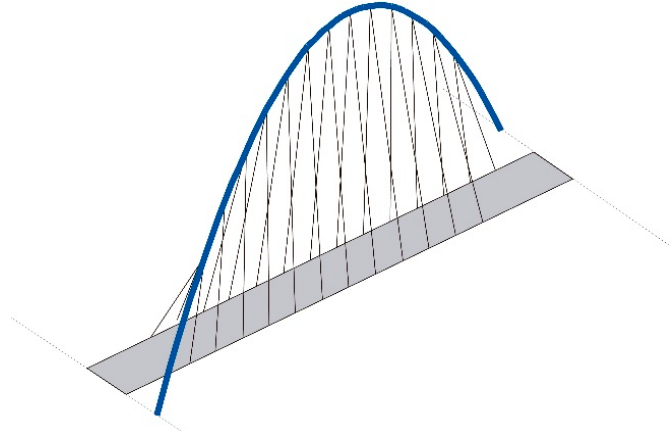
Figure 2. Schematic illustration of a diagonal arch bridge.